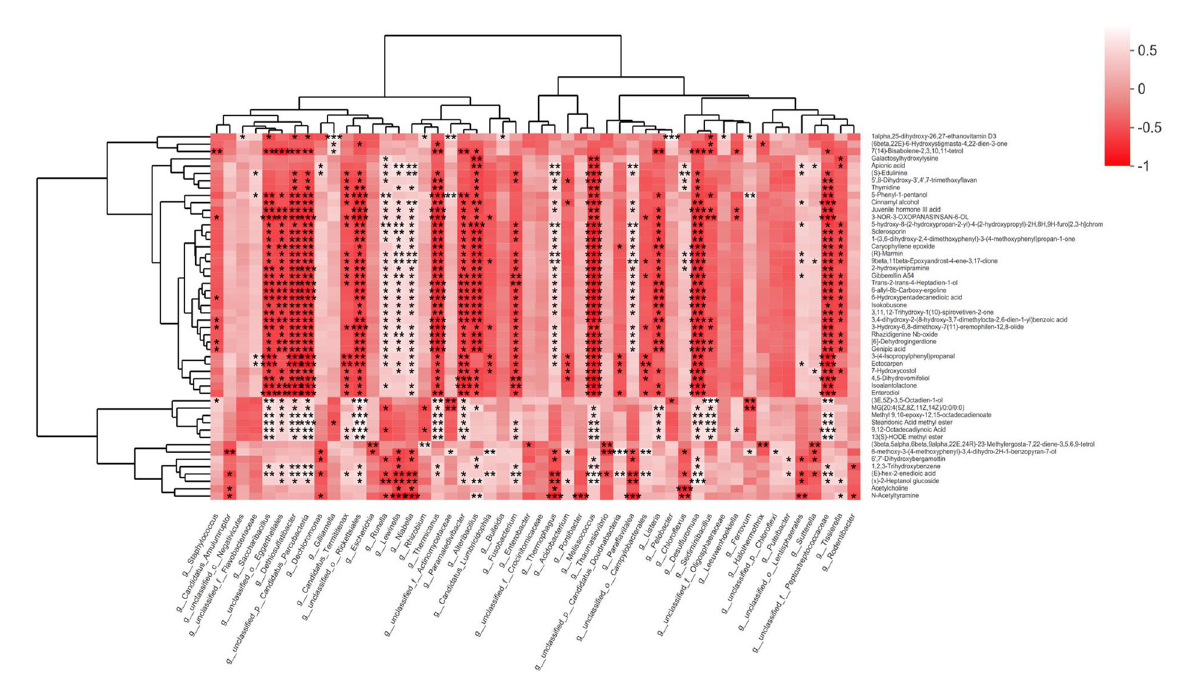
FIGURE6 Many bacteria are negatively correlated with metabolites. The bacteria are selected using the Kruskal–Wallis test on a genus level from fecal metagenomics data, and P < 0.01 of them are used. The metabolites are selected using the Kruskal–Wallis test from fecal LC-MS data, and P < 0.01 is used. The gradient colors represent the magnitude of the correlation coefficient; red indicates a negative correlation, and a white indicates positive correlation. * P < 0.05, ** P < 0.01, *** P <